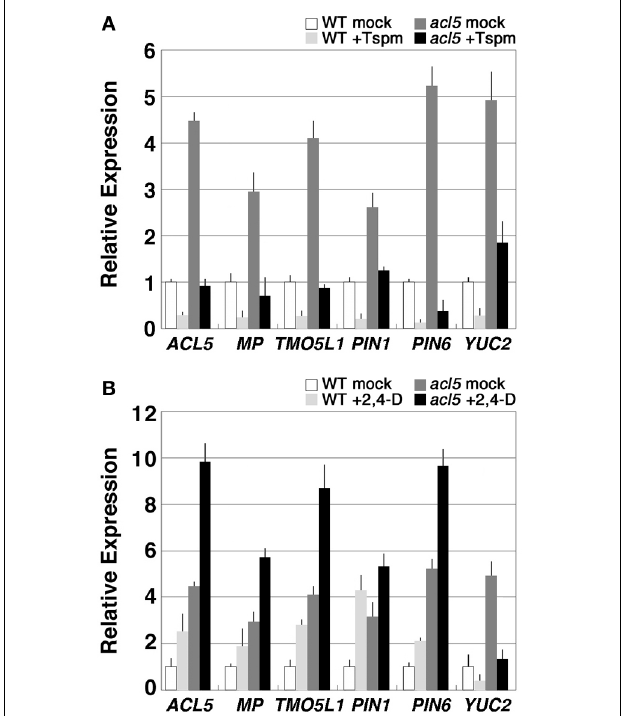
FIGURE 3 | Thermospermine down-regulates the genes that are involved in auxin biosynthesis, transport, and signaling in acl5-1 . (A) Effect of thermospermine on the expression of auxin-related genes. Transcript levels in wild-type seedlings treated for 24h with 100 µ M thermospermine (light gray bars), those in acl5-1 seedlings treated with mock (dark gray bars) and those in acl5-1 seedlings treated with thermospermine (black bars), are shown relative to those in wild-type seedlings treated with mock (white bars). (B) Effect of 2,4-D on the expression of auxin-related genes. Transcript levels in wild-type seedlings treated for 24h with 100 µ M 2,4-D (light gray bars), those in acl5-1 seedlings treated with mock (dark gray bars) and those in acl5-1 seedlings treated with 2,4-D (black bars), are shown relative to those in wild-type seedlings treated with mock (white bars). Error bars represent the SE ( n = 3).